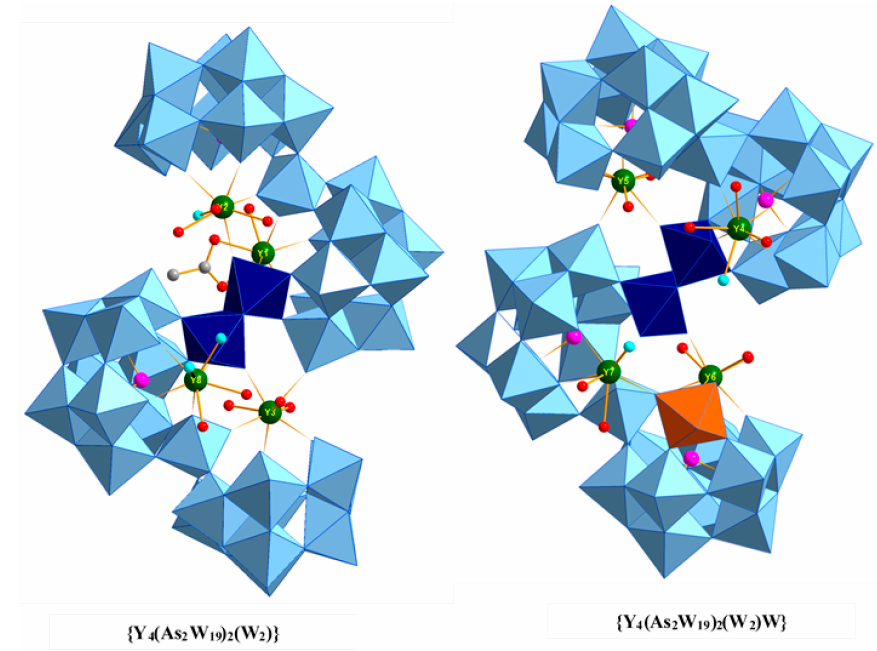
Figure 2. Combined polyhedral/ball-and-stick representation of the two half-units in 1. The turquoise balls represent bridging oxygens (O bridge ). The color code is the same as in Figure